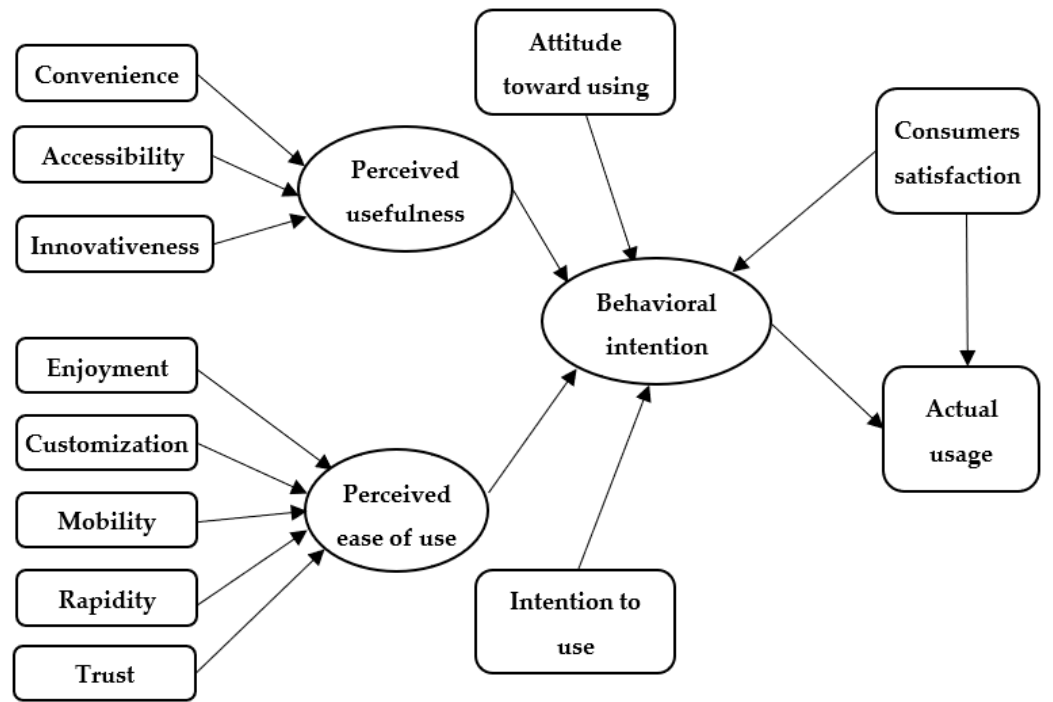
Figure 1. Conceptual structural model. Source: own construction based on [10,11,29–45,66–78].